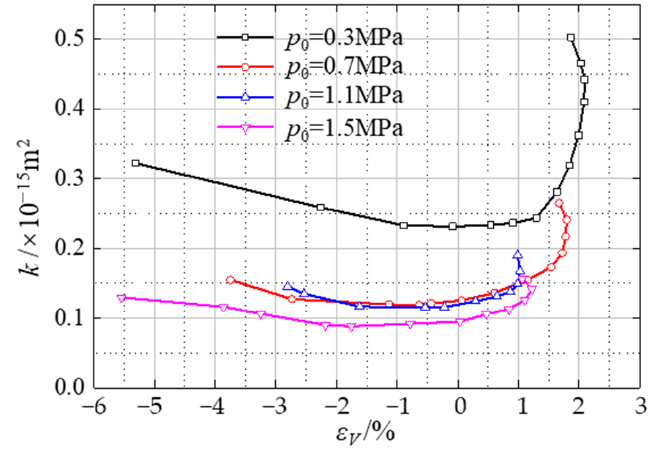
Figure 8. Relationship between permeability and volumetric strain of coal.